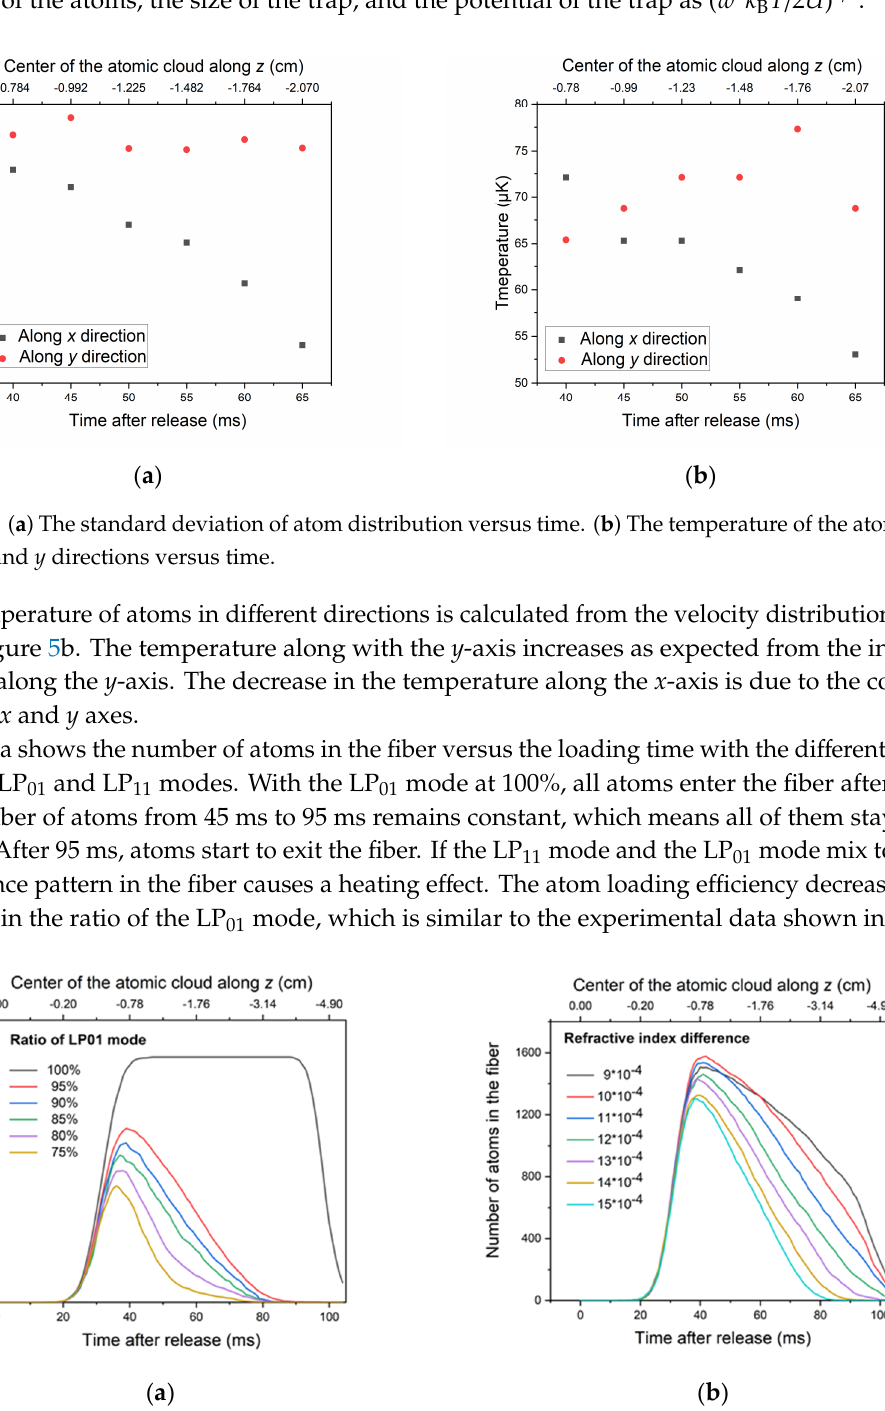
Figure 6. ( a ) Number of atoms in fiber versus time with different energy ratio of LP 01 mode. ( b ) The number of atoms in the fiber versus time with different effective refractive index differences.